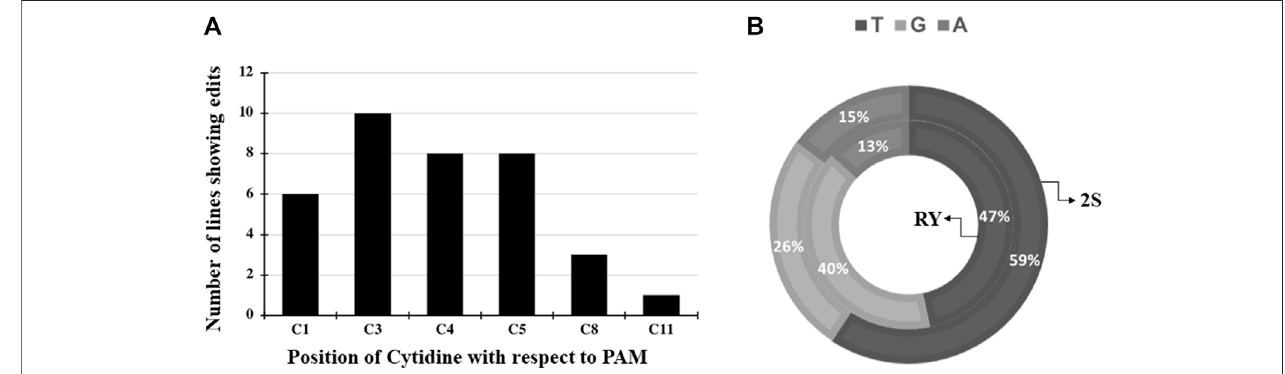
FIGURE 3 | Base editing induced conversion of cytidine to other bases at the RY and 2S targets (A) Combined base editing frequencies at different cytidine positions for both RY and 2S targets using pDW3873/PmCDA1; (B) Base substitution of C to T, G, A rates at the RY or 2S target by pDW3873/PmCDA1.